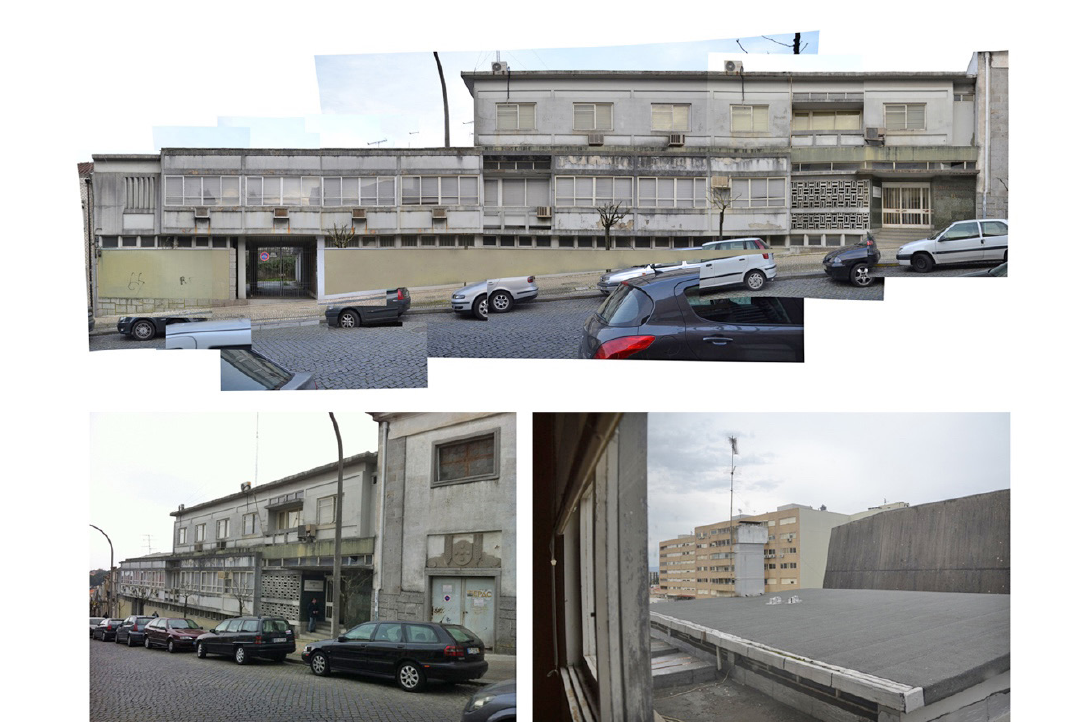
Figure 7. Current state of the Abade Loureira